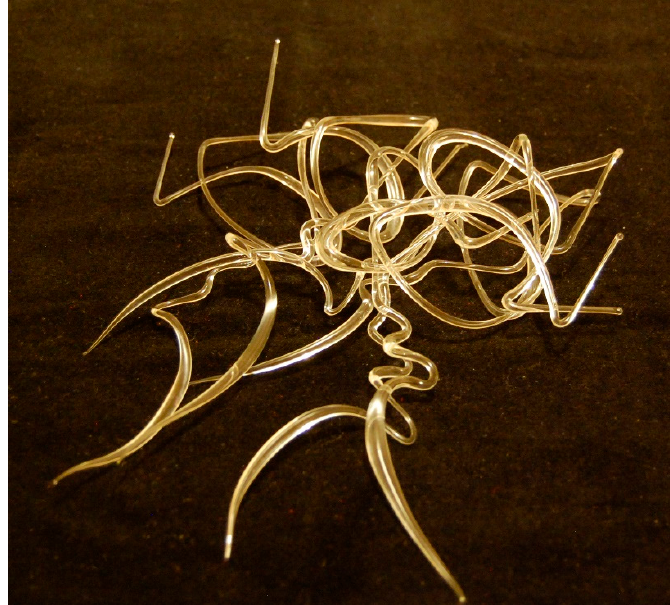
Figure 4. Rejected parts of Ghost by Ayako Tani.